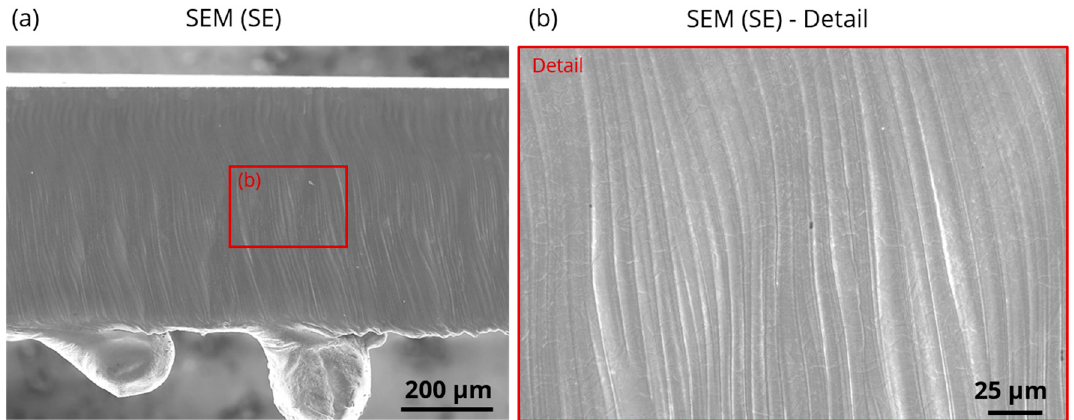
Figure 2. Obtained quality of the laser-cut surfaces of Ti-6Al-4V-ELI with non-optimized laser cutting conditions: ( a ) Overview SEM-image of the cutting edge with residual melting drops at the lower part; ( b ) Detailed SEM-image showing a wavy, irregular surface structure after the laser-cutting process.